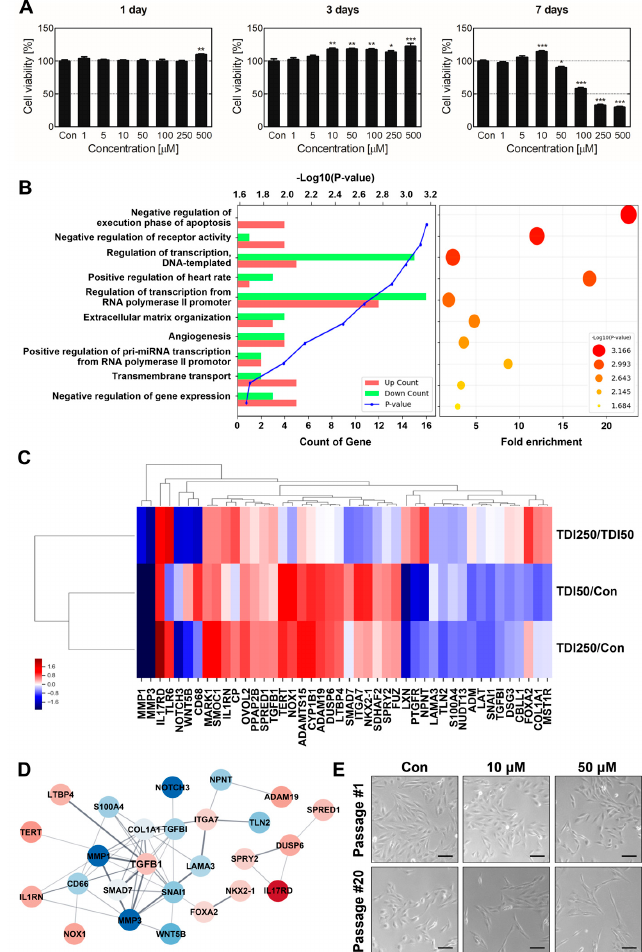
Figure 1. BEAS-2B transcriptional and morphological alteration after TDI treatment. ( A ) Cell viability was measured for TDI-exposed BEAS-2B cells after 1, 3, and 7 days. ( B ) After exposure to 50 μ M and 250 μ M of TDI for 24 h, gene ontology (GO) and gene set enrichment analyses were performed using 251 differentially expressed genes ( ≥ 2 folds, ≥ 5 normalized data values). ( C ) Hierarchical clustering was performed using a fold change value of 44 DEGs related to cancerous properties. Red-blue colors indicate relative changes in TDI50/Con and TDI250/Con gene expression. Similar expression patterns determined gene distance. ( D ) For 44 DEGs, a PPI analysis was conducted using the string database. Significantly increased or decreased genes are represented by red and blue nodes, respectively. Connected nodes have a significant co-expression relationship demonstrated by bold lines. ( E ) BEAS-2B morphological changes during short-term and chronic TDI exposures were observed by microscope. Chronic TDI exposure led to morphological alterations, including cell elongation and shape change. Every experiment was performed over three times. * p < 0.05; ** p < 0.01; *** p < 0.001 compared to the control group; TDI250: 250 μ M of TDI; TDI50: 50 μ M of TDI; Con: control; Scale bars: 50 μ m.